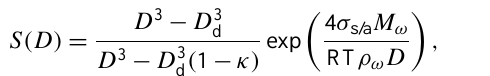
Figure 10. Scatterplots of predicted and measured CCN concentra- tions (cm − 3 ) at different SS conditions, the red dash line represents y = x